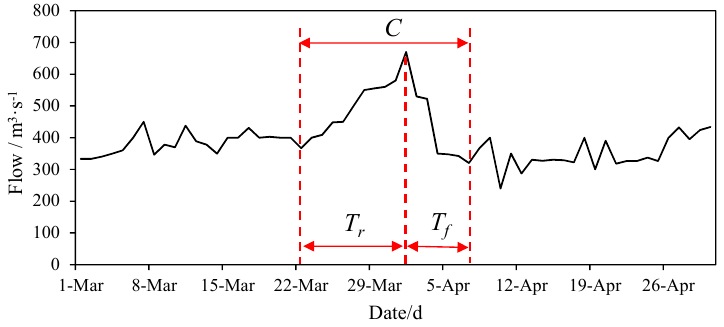
Figure 2. Schematic diagram of the index definition.